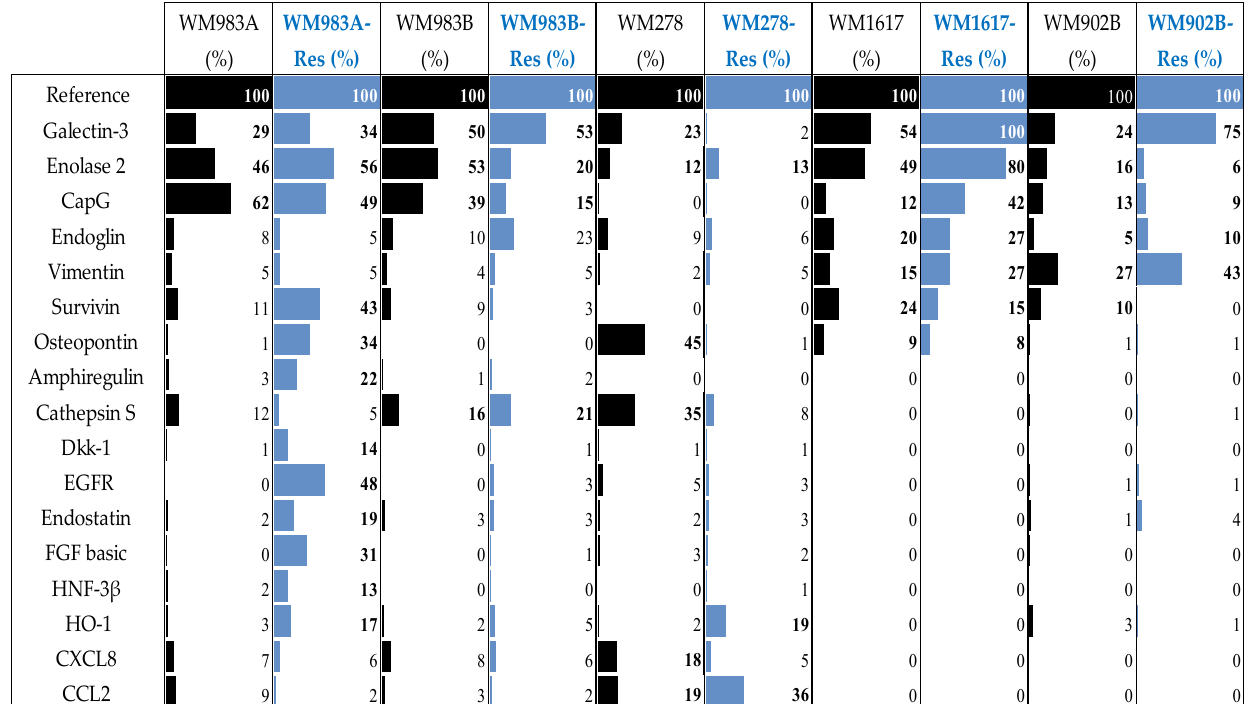
Figure 4. Protein expression profiles of BRAFi/MEKi-sensitive (black columns) and -resistant (blue columns) melanoma cell lines. Protein expressions were analysed using the Proteome Profiler Human XL Oncology Array. Proteins with detectable differences (>10%) in at least one cell line are shown. The intensity of the reference is displayed as 100%. Numbers in the columns indicate the protein expression as a percentage of the intensity of the reference spots on the array.